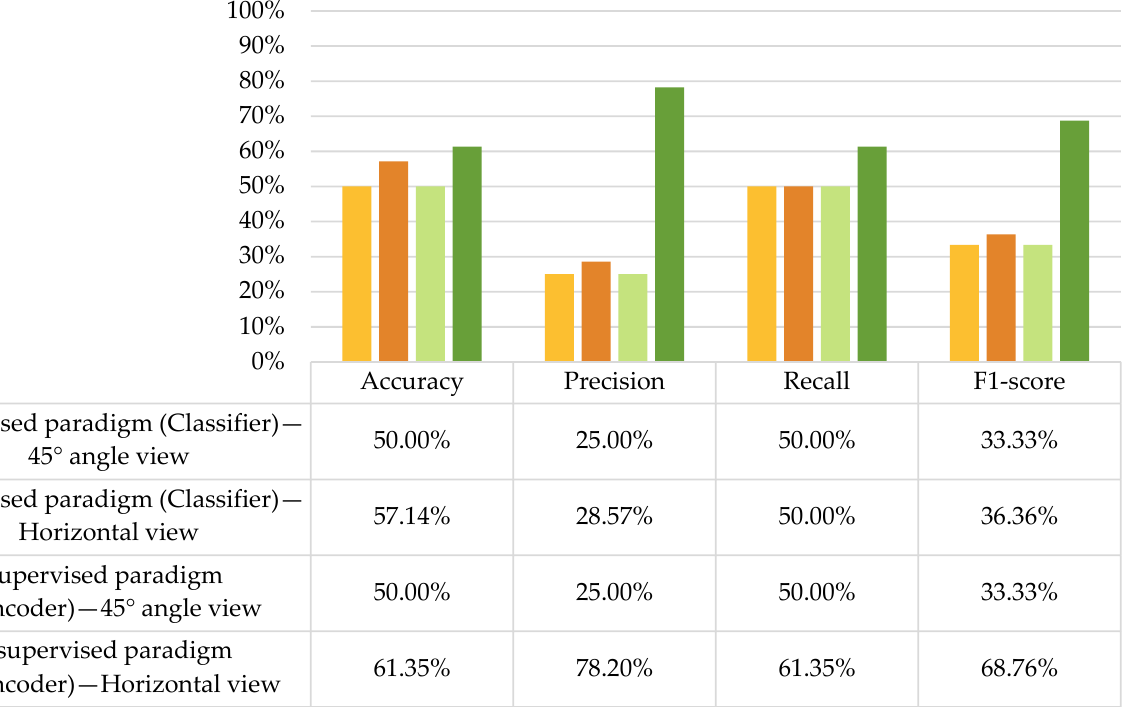
Figure 9. Comparative analysis of the unsupervised single autoencoder vs. the supervised classifier approach for the different capturing positions of the RGB camera.